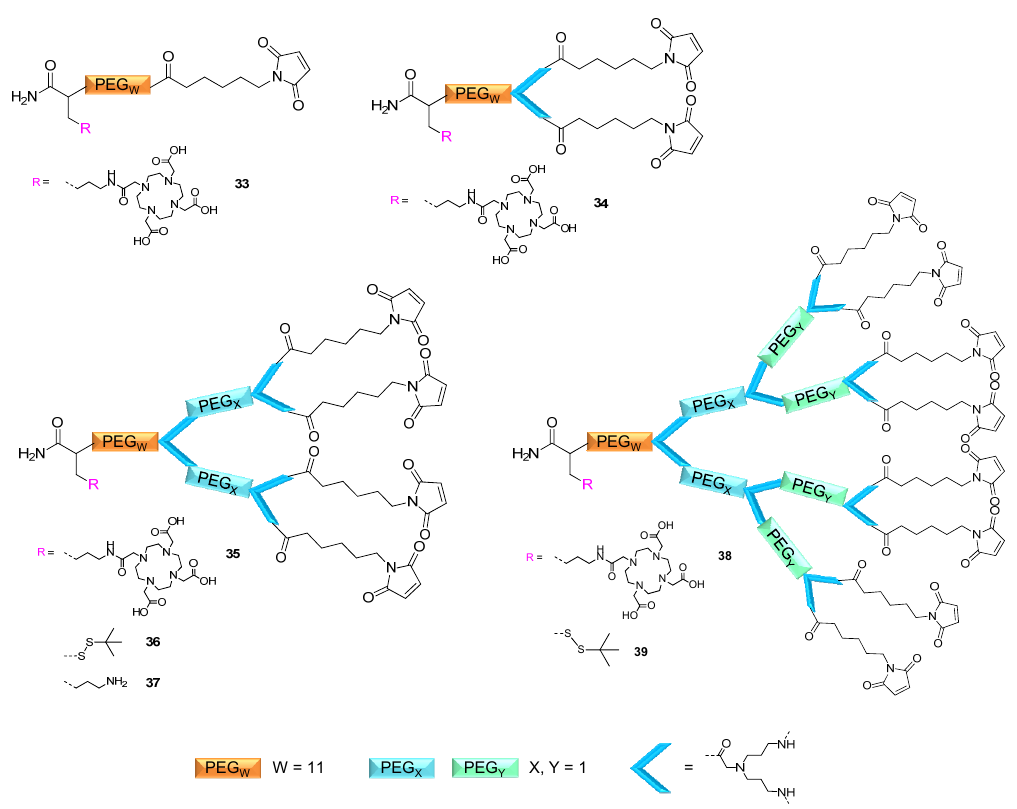
Figure 7. Schematic depiction of the synthesized mono/multivalent maleimides 33 – 39 comprising either a t Bu-thio-protected thiol functionality for bioconjugation or a DOTA chelator for radiometal